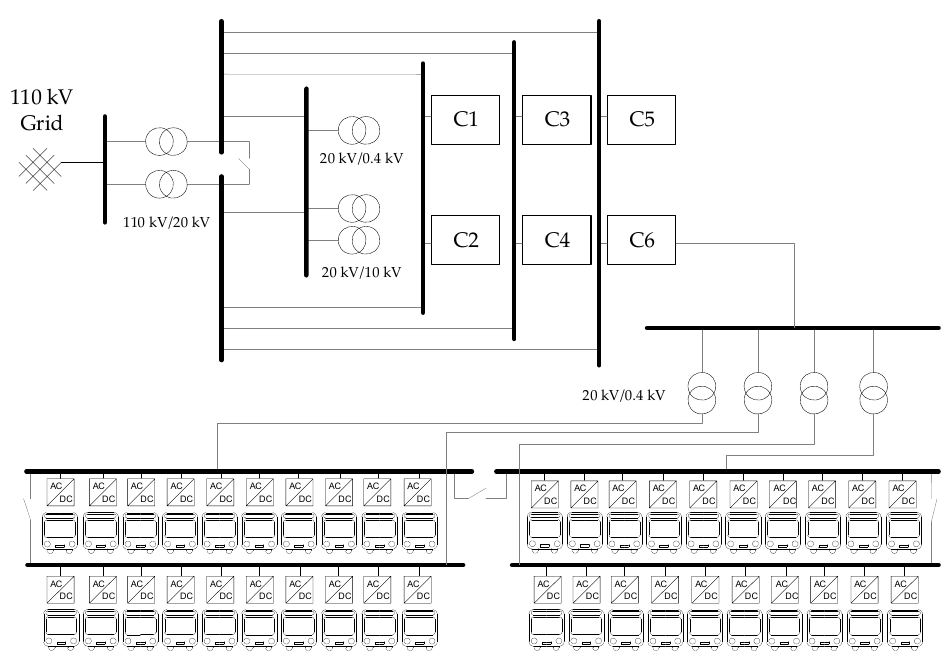
Figure 1. Electrical infrastructure on the Bus Depot Alsterdorf with the detailed representation of the Carport No. 6.